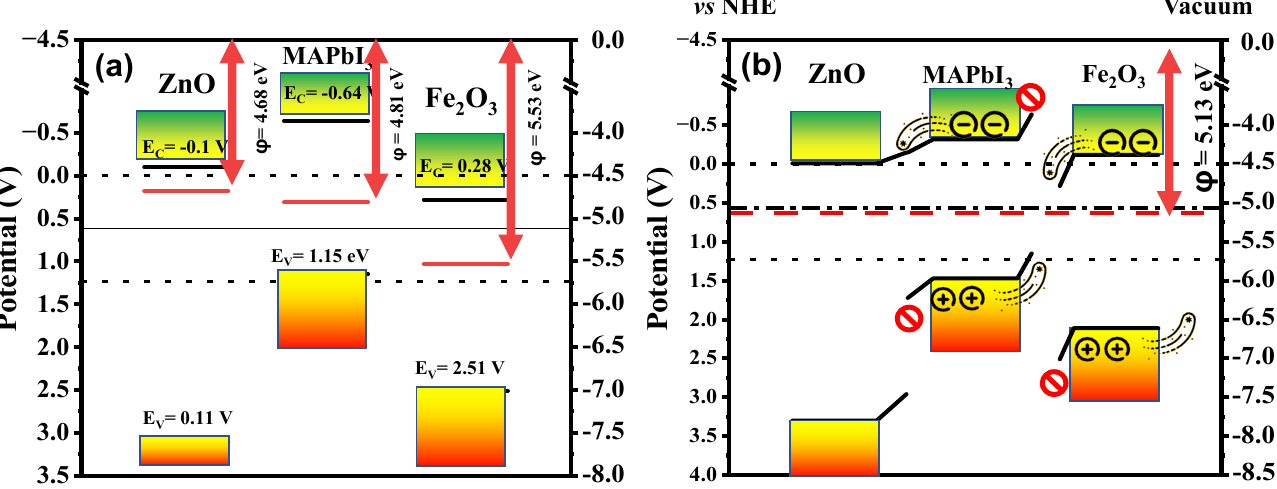
Figure 3. A schematic diagram of band edge potentials for ( a ) the ZnO:Al/MAPbI 3 /Fe 2 O 3 het- Figure 3 . A schematic diagram of band edge potentials for ( a ) the 𝑍𝑛𝑂:𝐴𝑙/𝑀𝐴𝑃𝑏𝐼 (cid:2871) /𝐹𝑒 (cid:2870) 𝑂 (cid:2871) hetero- structure, where ϕ denotes the work function, ( b ) freestanding ZnO:Al, MAPbI 3 , and Fe 2 O 3 . erostructure, where φ denotes the work function, ( b ) freestanding ZnO:Al, MAPbI 3 , and Fe 2 O 3 Therefore, it is not possible for the redox half reactions H + /H 2 and O 2 /H 2 O to occur, because the bottom of the CB is found at − 0.64 V vs. NHE, and the VB for Fe (cid:2870) O (cid:2871) consists